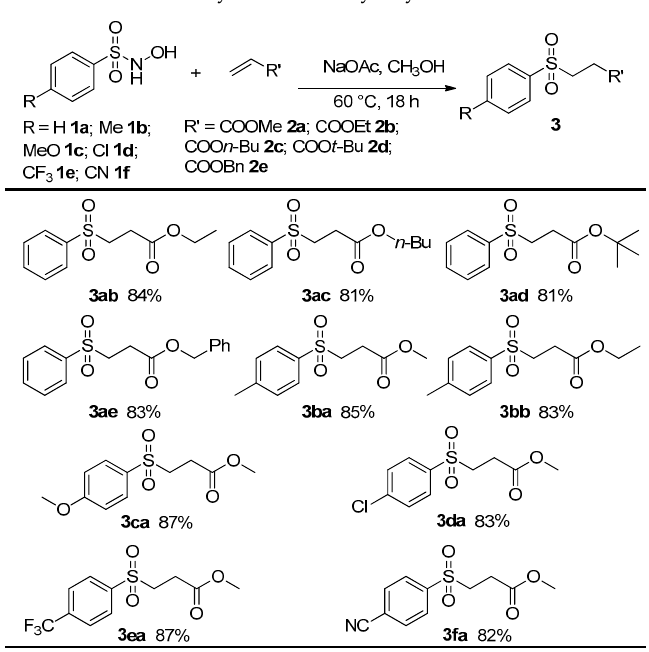
Table 2. Synthesis of alkyl aryl sulfones a .